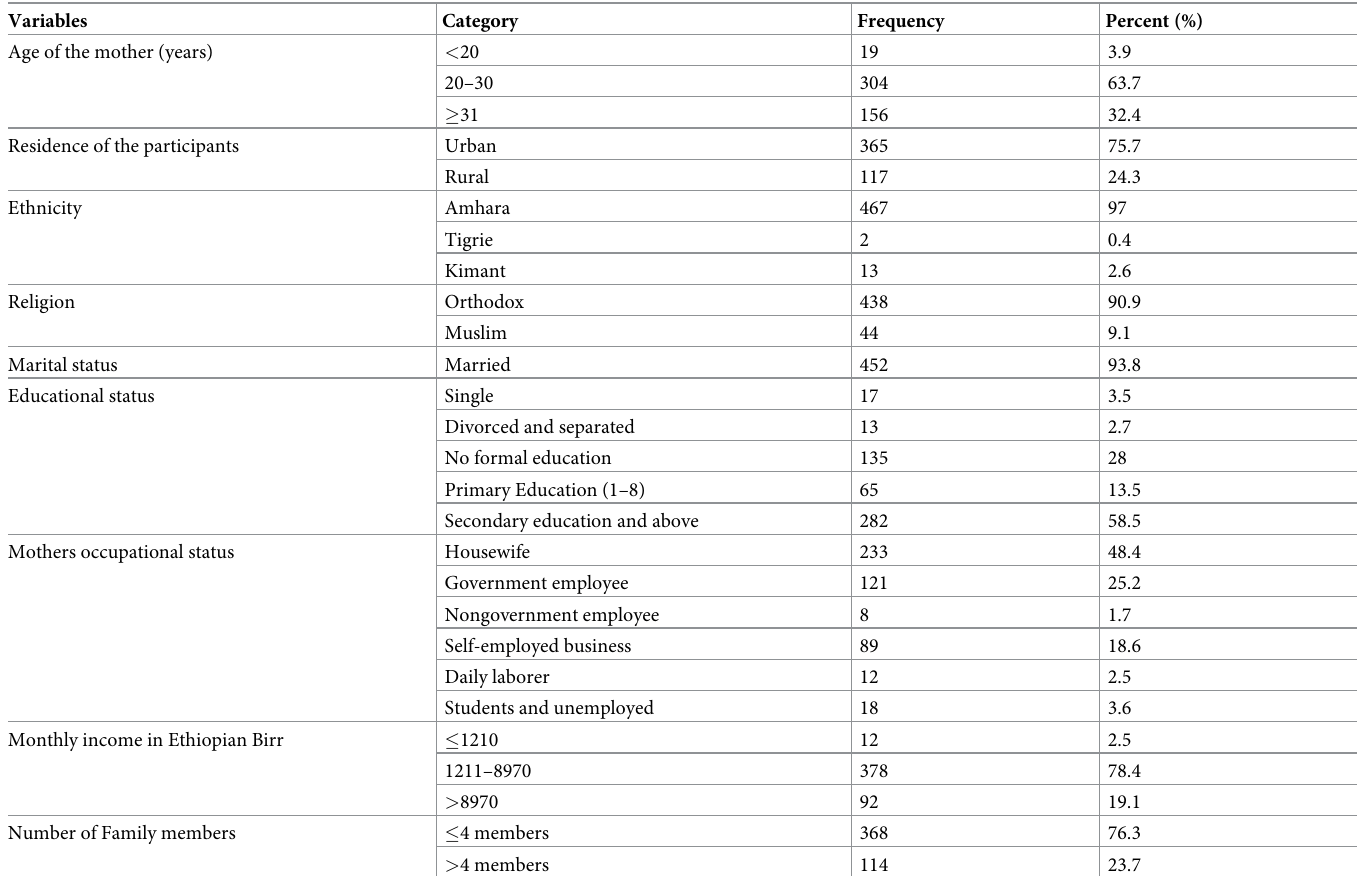
Table 1. Socio-demographic characteristics of the study participants in governmental referral hospital, Amhara Region, Northwest Ethiopia 2020 (n =